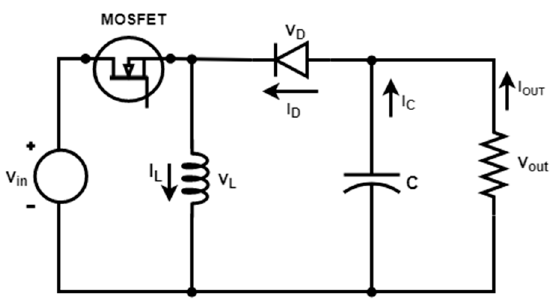
Figure 5. Proposed buck–boost converter.